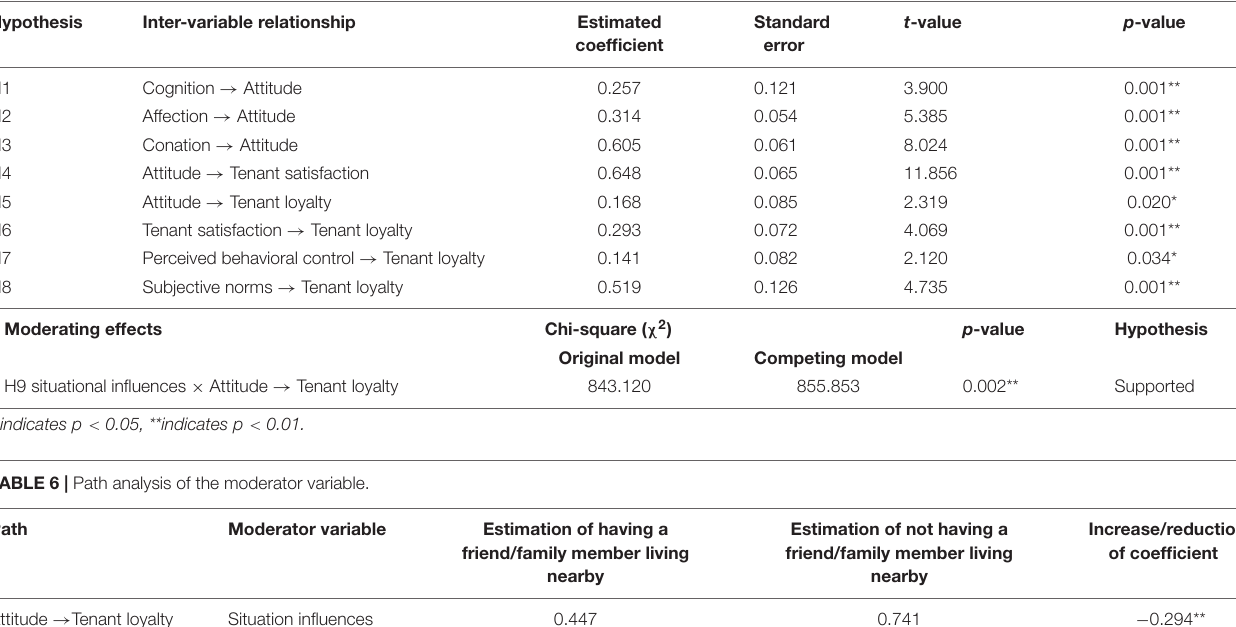
TABLE 5 | Estimation results of linear structural equation modeling.